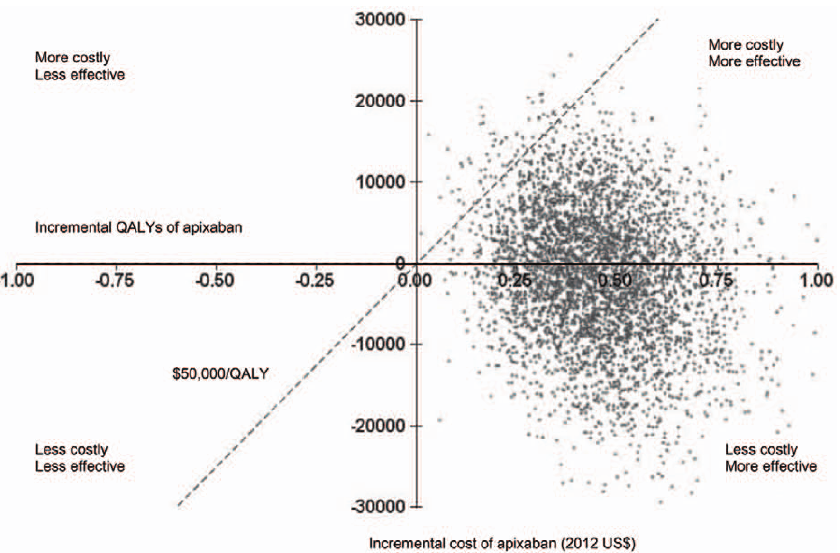
Figure 4. Incremental cost-effectiveness plane. Incremental cost-effectiveness plane showing Monte Carlo estimates of incremental costs and benefits of using apixaban for stroke prevention versus adjusted-dose warfarin. For each one of the 10,000 iterations, values for parameters are randomly selected from their distributions and an ICER is calculated. Points falling above the dotted line have an ICER of . $ 50,000 per QALY and those falling below the line have an ICER of , $ 50,000 per QALY. Apixaban was found to be a dominant strategy (less costly, more effective) in 57% of the simulations and cost-effective in 98% of simulations at willingness-to-pay thresholds of $ 50,000 per QALY. Four thousand of the 10,000 iterations, selected at random, are depicted. ICER = incremental cost-effectiveness ratio; QALYs = quality-adjusted life-years.